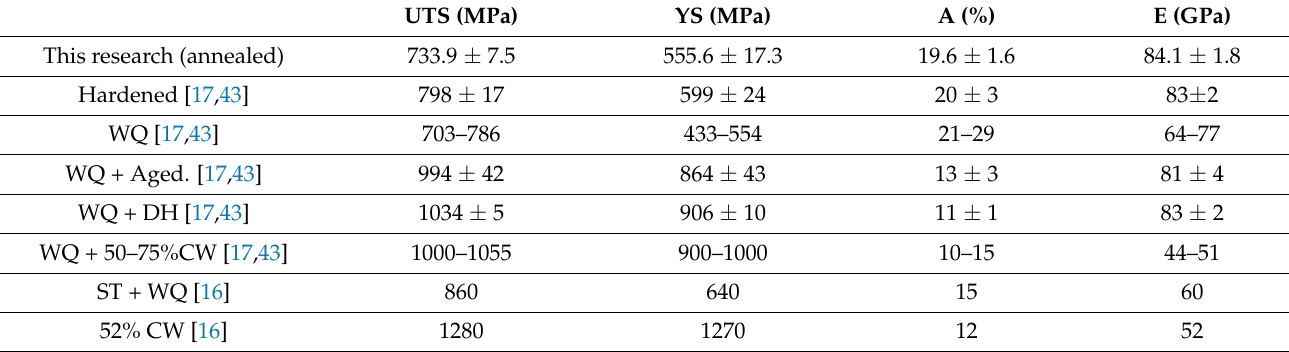
Table 8. Comparison of the mechanical properties of Ti-13Nb-13Zr material with various heat treatment